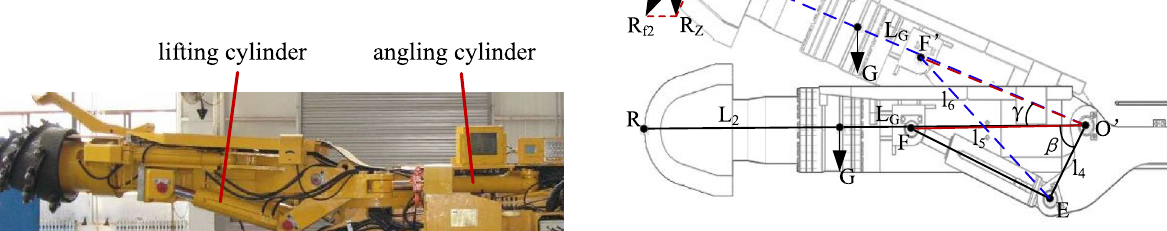
Fig. 3 Picture of real product of the cutting arm